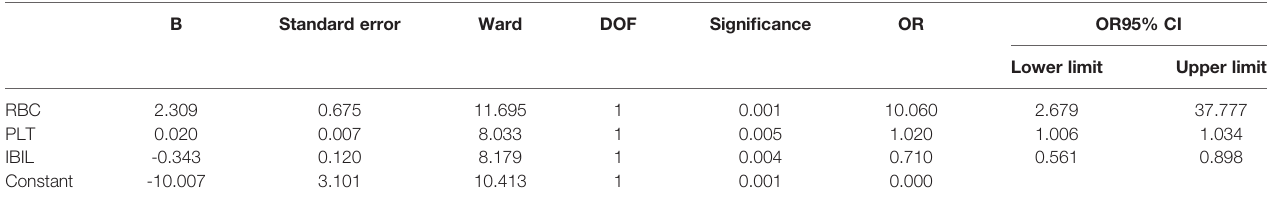
TABLE 5 | Multivariate analysis.